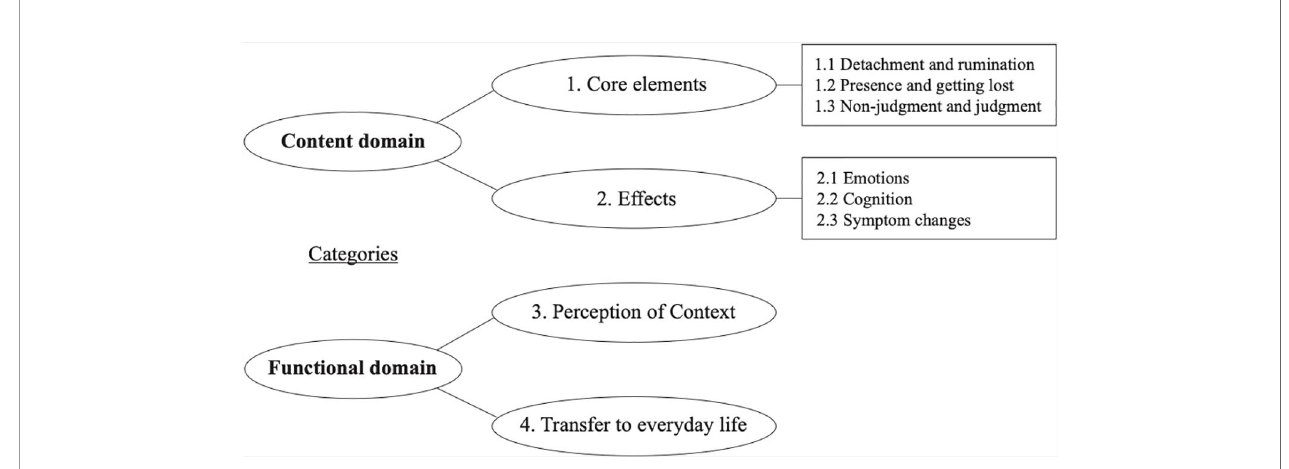
FIGURE 2 | Summary of